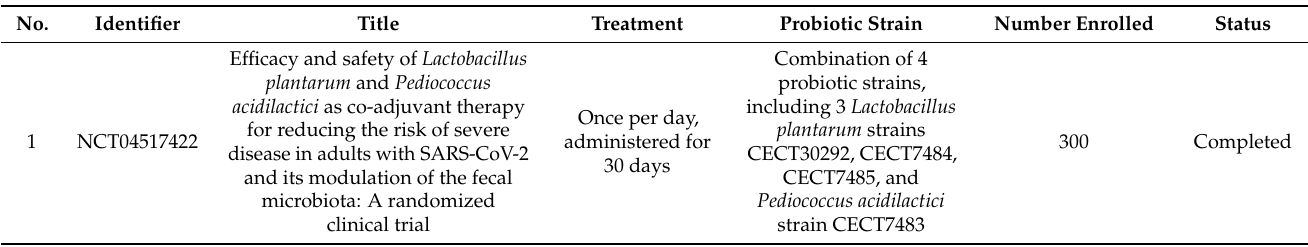
Table 1. Clinical trials on the effect of consuming probiotics against COVID-19. The data is up-to-date as of 28 November 2021, retrieved from https://clinicaltrials.gov/. The search query was “condition or disease” = “covid19”, “other terms” =